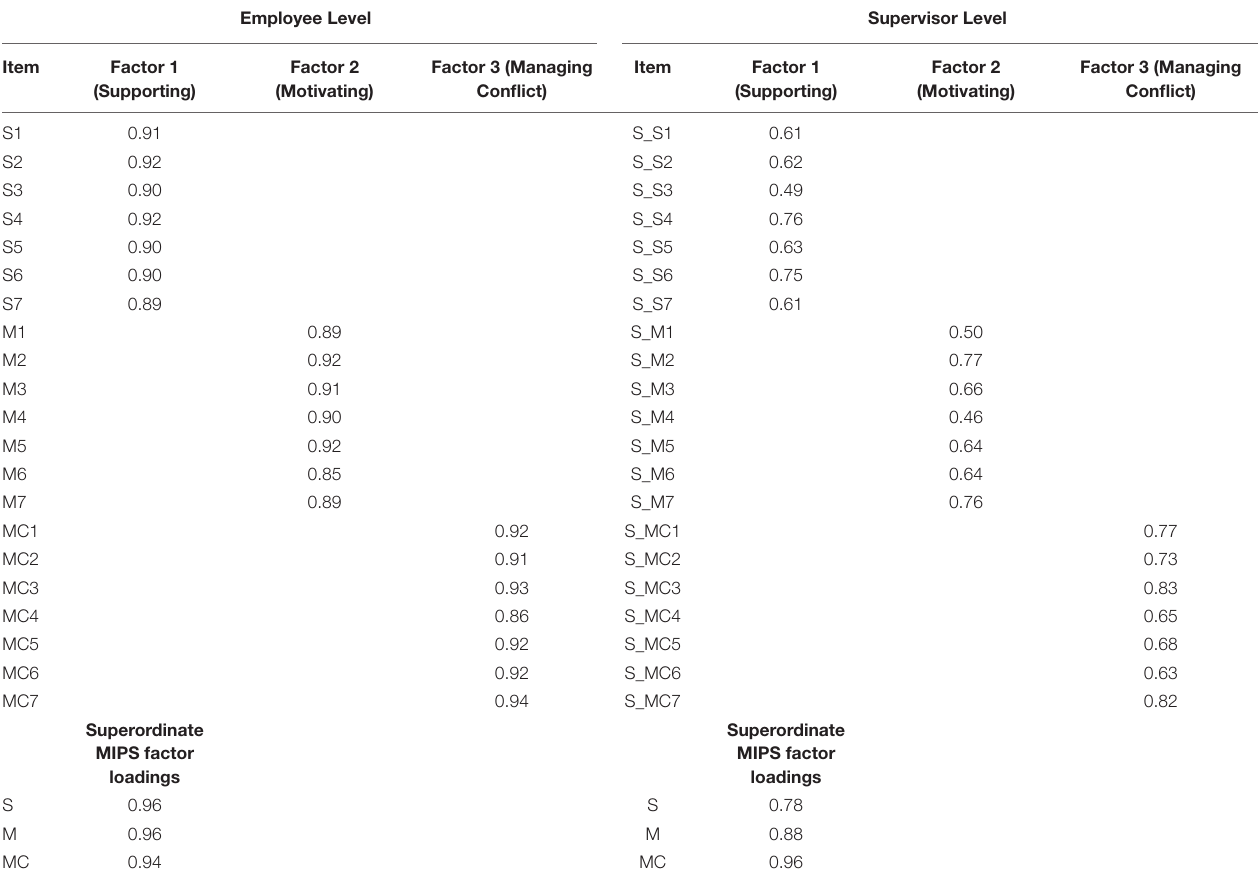
TABLE 6 | Study 4: CFAs with Level 1 Employee Ratings and Level 2 Supervisor Self Ratings of